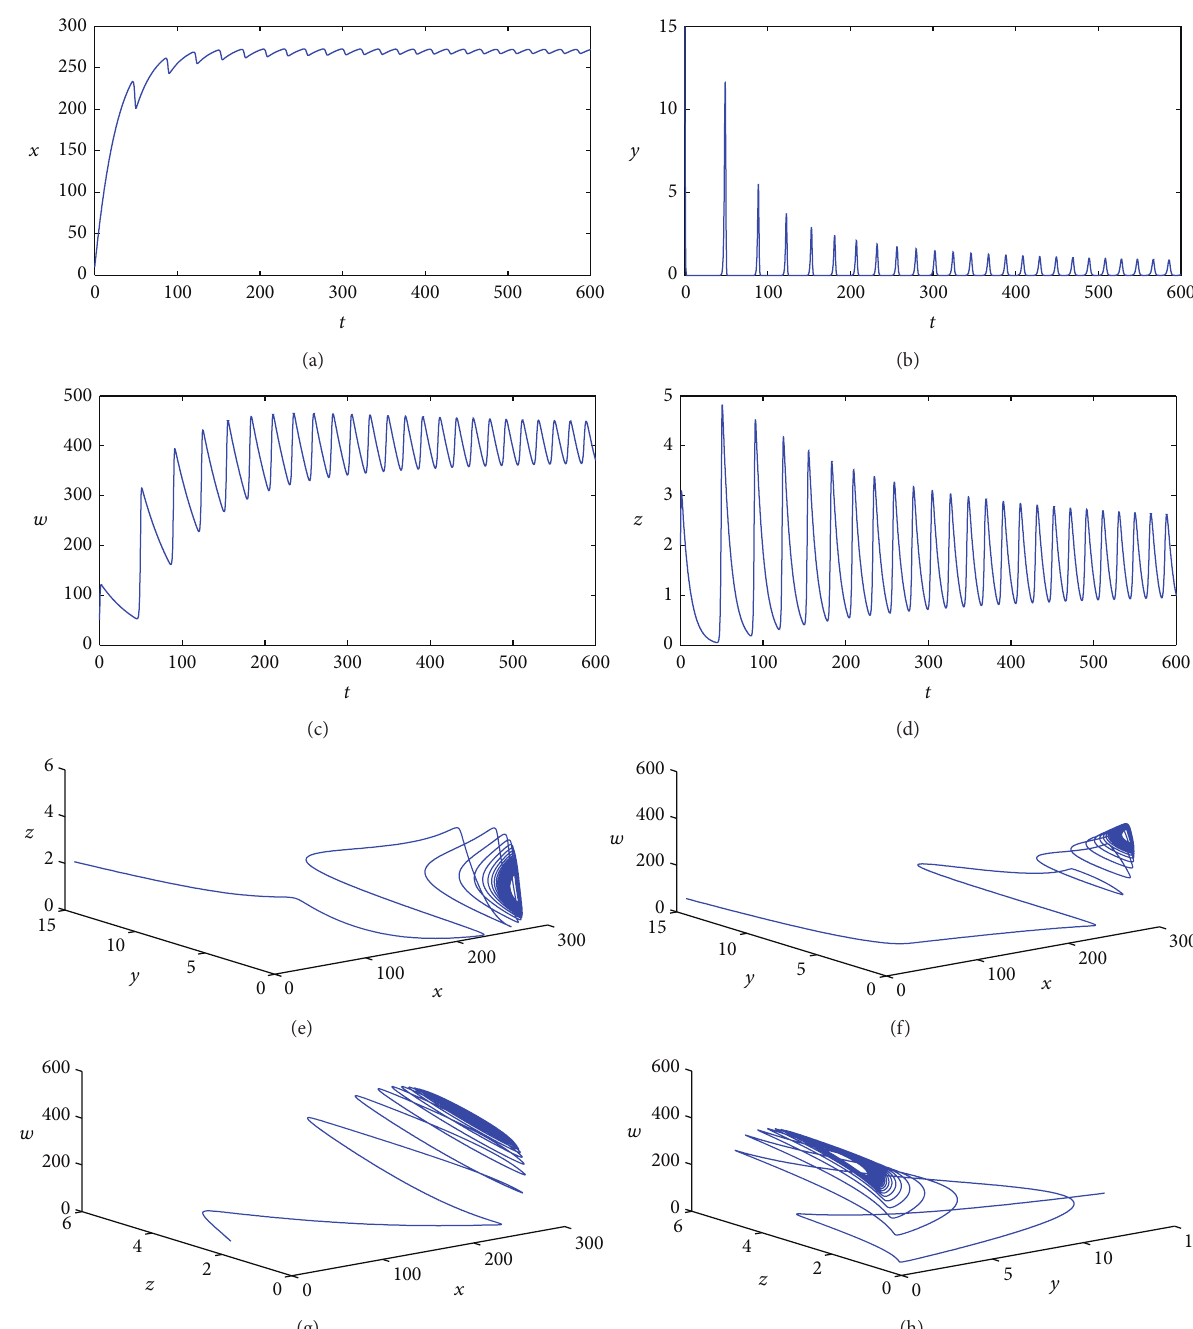
Figure 3: It shows the numerical simulations of model (4), when the time delay of immune activation exceeds the critical value, 𝜏 = 0.5 > 𝜏 0 . The endemic steady state E + of the model undergoes Hopf bifurcation; stability switch and periodic solutions appear.